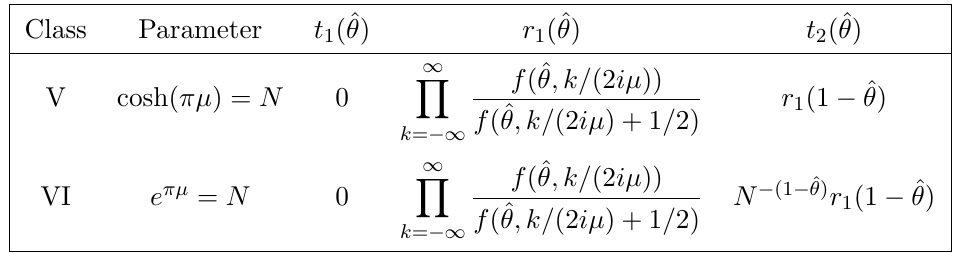
Table 2 . Classes V and Class VI of U( N ) minimal solutions. Note that the parameter (cid:22) is a real